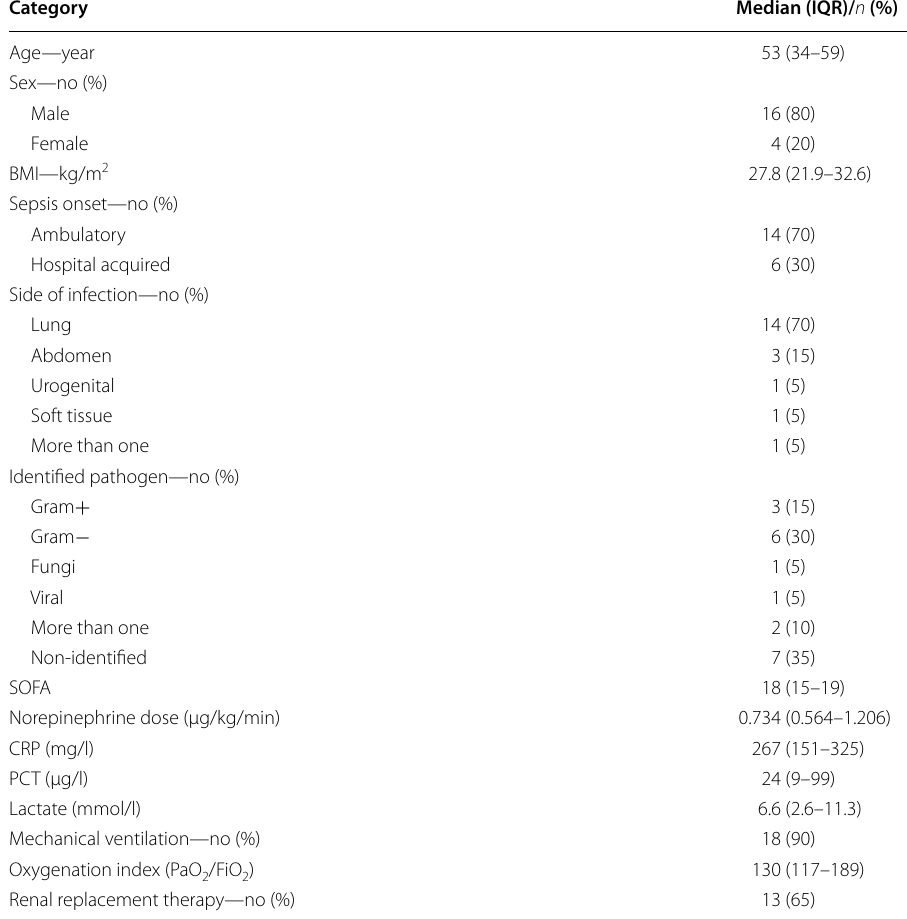
Table 1 Demographic and clinical characteristics at